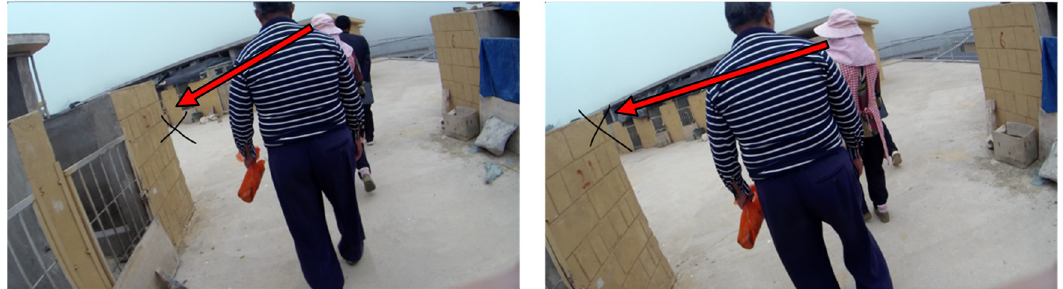
Figure 9: BLW and MSN, the frontrunners, direct their gaze and bodies to the left - hand road.